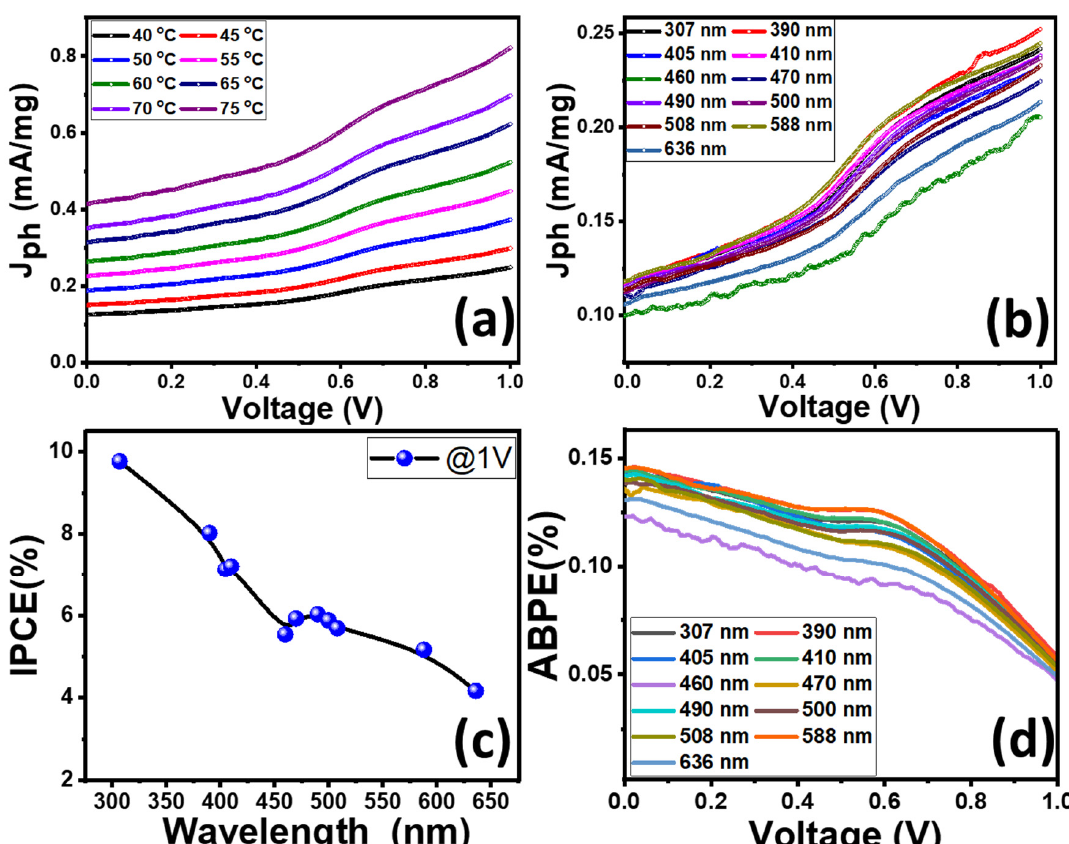
Figure 8. ( a ) Effect of ( a ) temperature and ( b ) wavelength of the monochromatic illumination on the J ph –V curves; conversion efficiencies ( c ) IPCE% versus the monochromatic wavelength and ( d ) ABPE% versus the applied bias at different wavelengths for RW >0.3 sample.